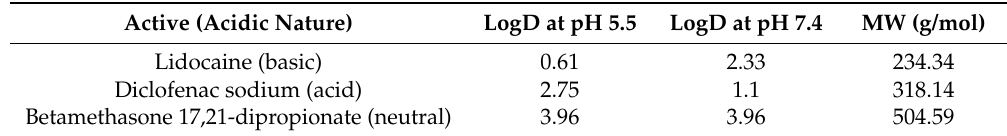
Table 3. Molecular weight (MW) and octanol water distribution coefficients (LogD) at pH 5.5 and 7.4 obtained from the ChemAxon